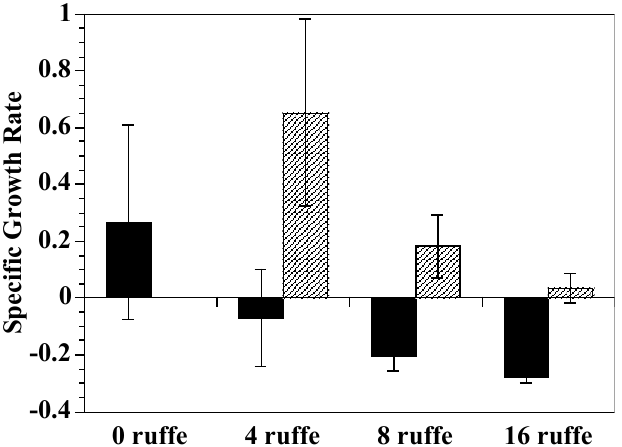
Figure 3. The effect of increasing ruffe density on specific growth rates of ruffe (striped columns) and yellow perch (solid columns) over the two five-week trials of the fish density gradient experiment (August–October 1997). Treatments consist of four replicates each of 0, 4, 8, and 16 ruffe added to 8 yellow perch. Treatment means are shown plus or minus one standard error.